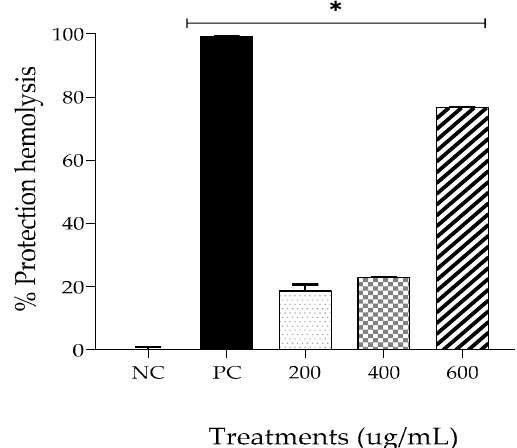
Figure 6. Mean ± SD of the percentage of protection against hemolysis for each treatment group: negative control (NC; physiologic solution 0.9%), positive control (PC; 100 µ g/mL, dexamethasone), and EPPR (200 µ g/mL, 400 µ g/mL, and 600 µ g/mL). The asterisk (*) indicates a significant